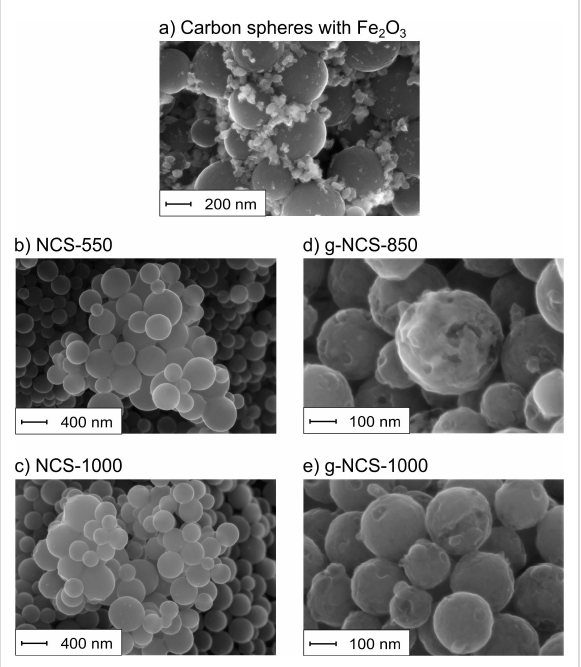
Figure 2: SEM images of (a) the carbon spheres with Fe 2 O 3 before acid treatment, (b, c) the different non-graphitized and (d, e) the graphitized carbon spheres.